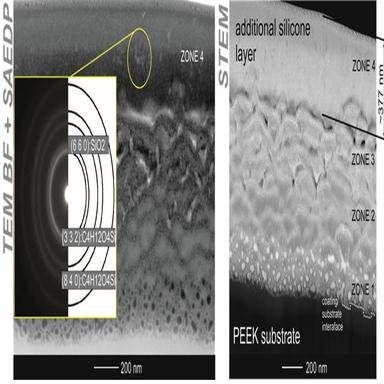
Qualitative chemical analysis of the modified coating performed by EDS; a). STEM image with the marked line for EDS analysis and b). diagram of the selected elemental distribution along the line.